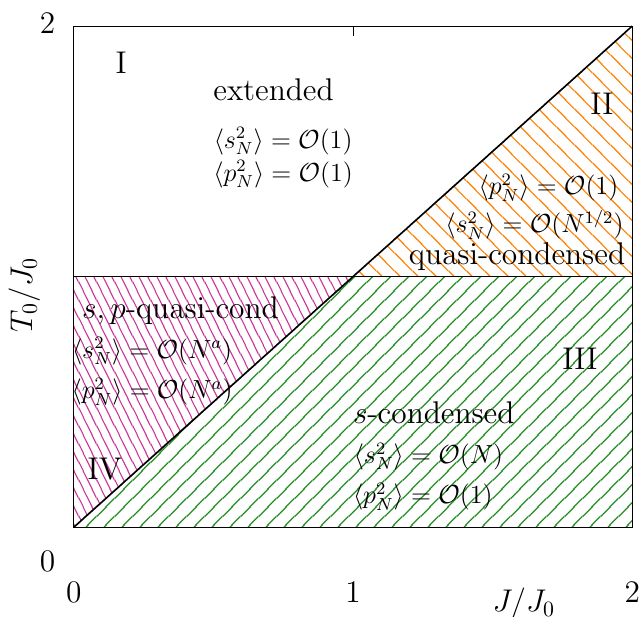
Figure 5: The dynamic phase diagram. The names of the phases refer to the scaling 〉 and 〈 p 2 〉 (both averaged over the GGE or the dynamics) with N and the of 〈 s 2 N N consequent condensation or quasi-condensation phenomena, see the explanation in the text. All transition lines are